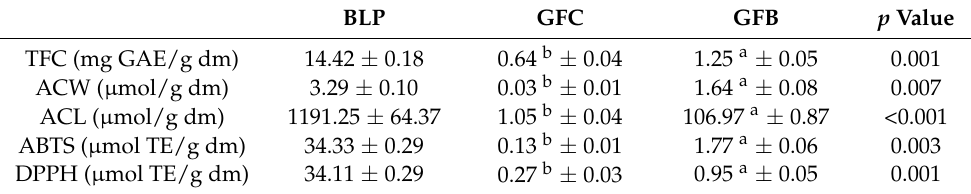
Table 5. Antioxidant capacity of experimental gluten-free